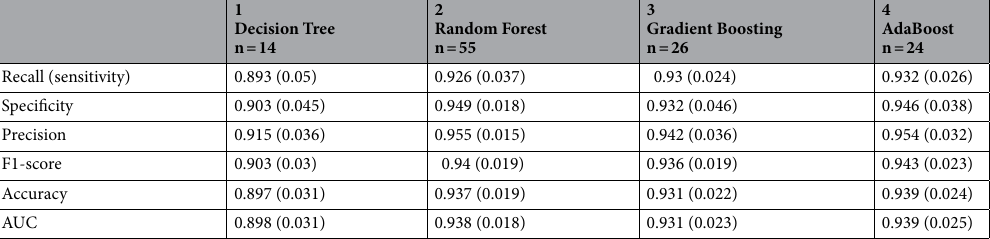
Table 4. Performance metrics when including the first n important features of each model. The value of n is indicated in the header of each column. For each metric, we present the mean value and standard deviation based on ten-fold cross-validation.